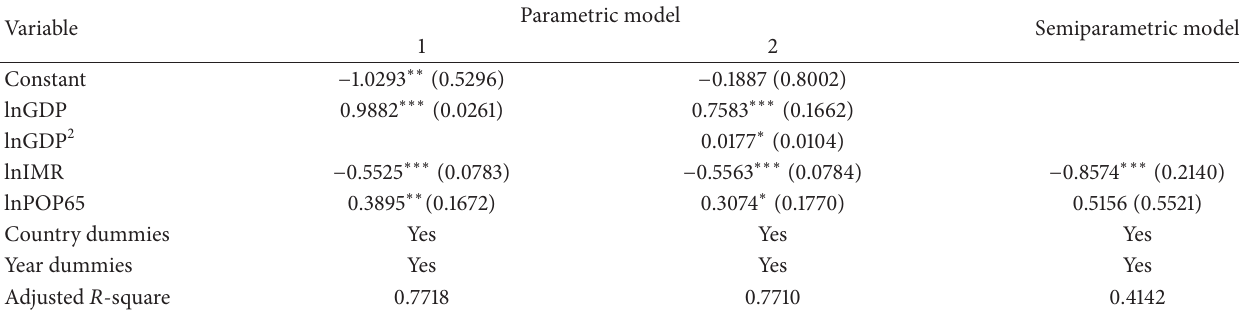
Table 2: Parametric estimation results.